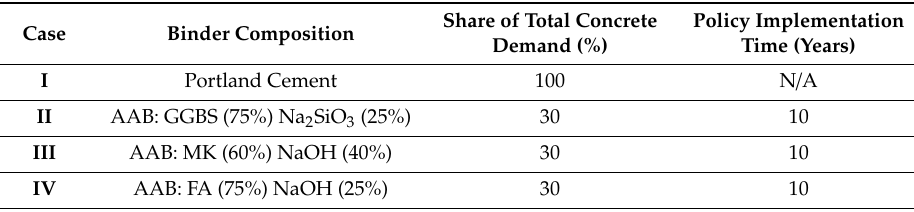
Figure 12. Sensitivity analysis exhibiting the effect of AAB carbonation rate on ( a ) total carbonation and, ( b ) total CO ₂ emissions released by the year 2050. Table 1. Single precursor system.